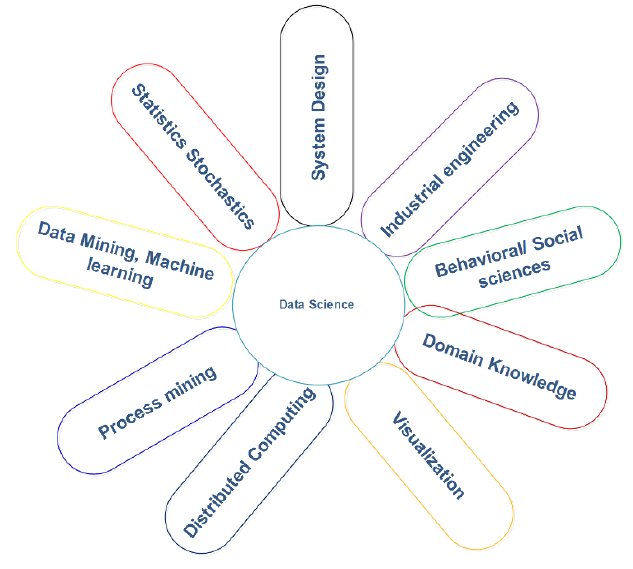
Figure 7. Data science.